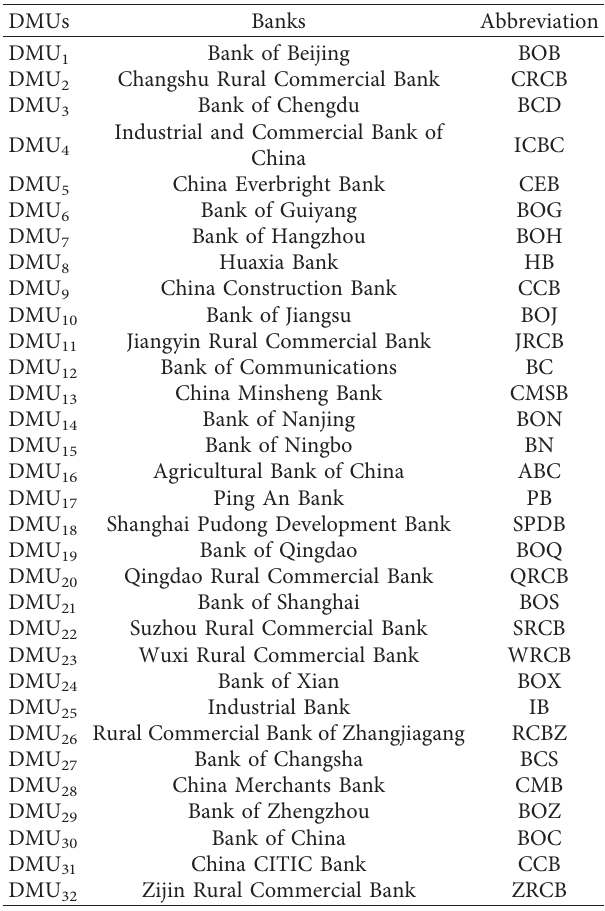
Table 1: Codes for 32 Chinese listed banks.